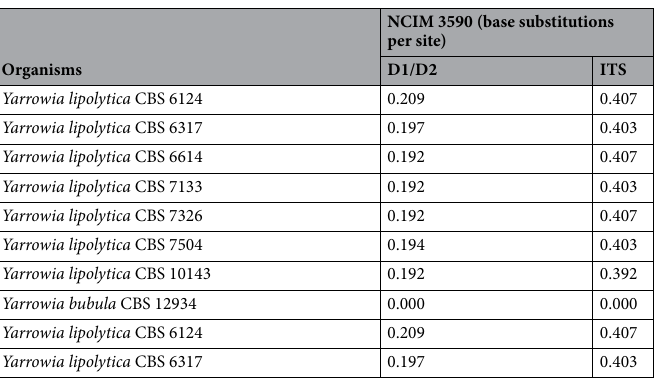
Table 1. Evolutionary distances between NCIM 3590 and various Y. lipolytica and Y. bubula strains using GTR + G + I model a . a Evolutionary distances between pairs of sequences are shown. Analyses were conducted using the General Time Reversible model. This analysis involved 30 nucleotide sequences There were a total of 403 positions (sites) for D1D2 and 314 (sites) for ITS in the final dataset. Evolutionary analyses were conducted in MEGA